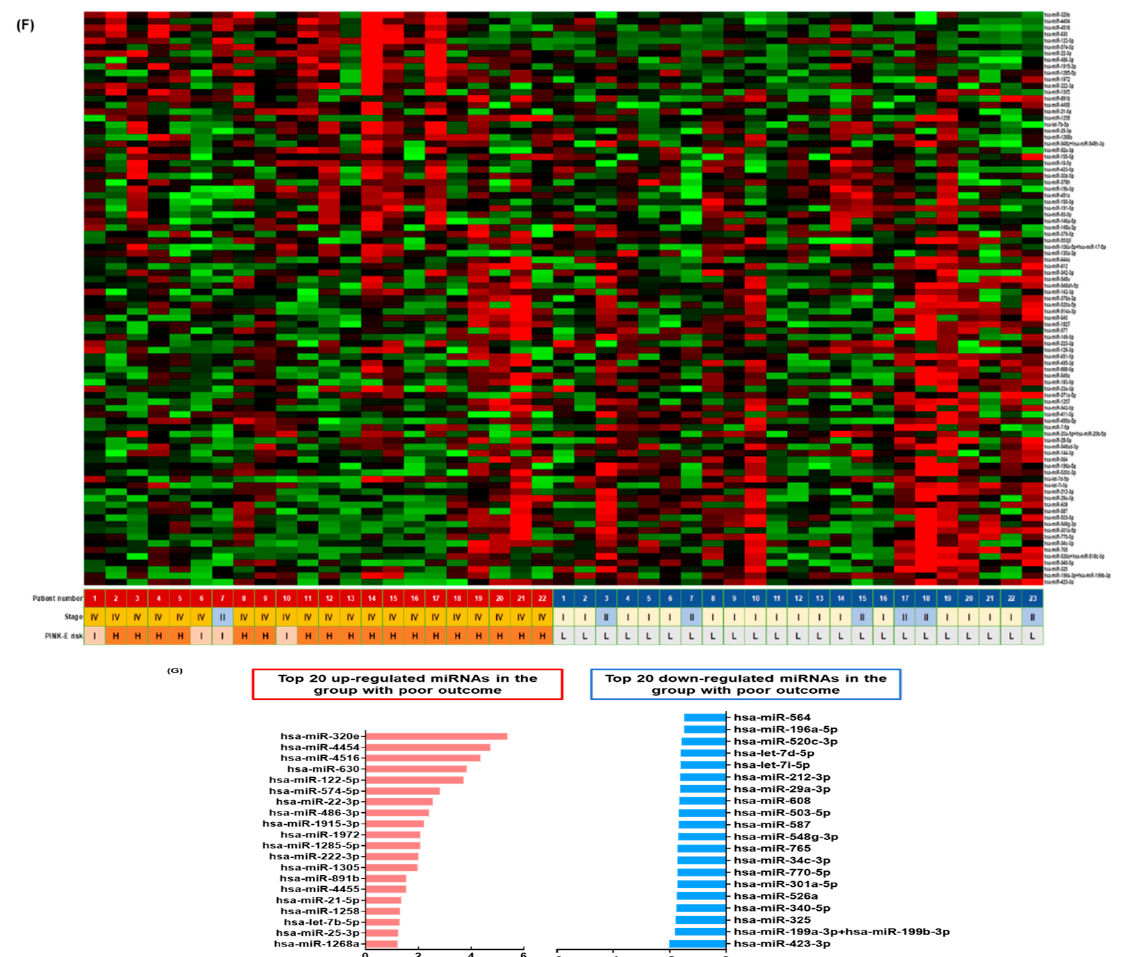
Figure 1. Characterization and miRNA analysis of exosomal miRNA in NK/T-cell lymphoma (NKTL) patients. ( A ) Exosomes were isolated by ExoQuick from equal volumes of serum of NKTL patients; their size and concentration were analyzed by transmission electron microscopy (TEM). Scale bar =100